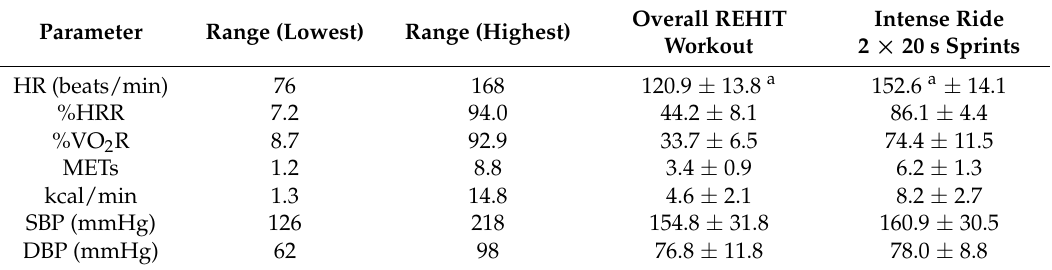
Table 2. Acute cardiovascular and metabolic responses to the REHIT workout.